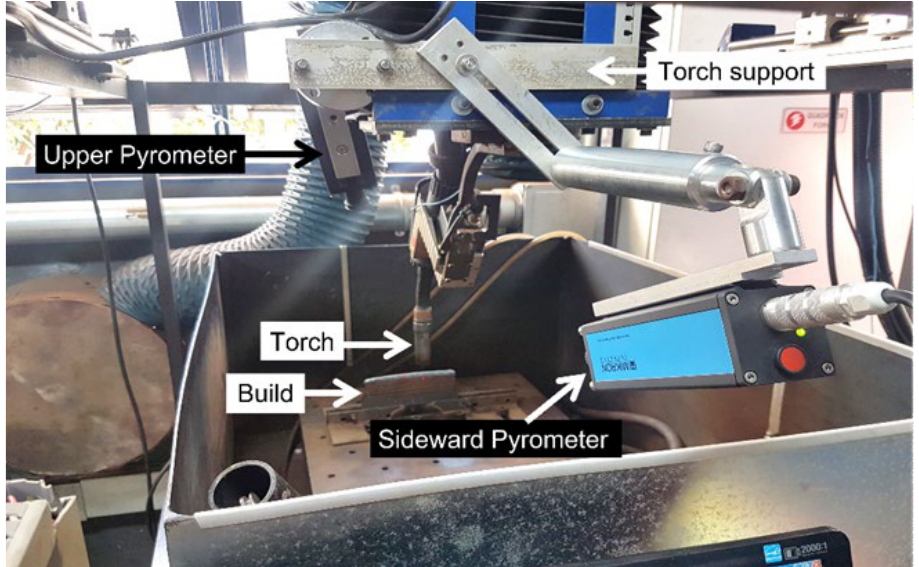
Figure 3. Experimental rig with the two pyrometers fixed in the torch support and positioned to measure with the strategies Upper Pyrometer and Sideward Pyrometer accordingly. measure with the strategies Upper Pyrometer and Sideward Pyrometer